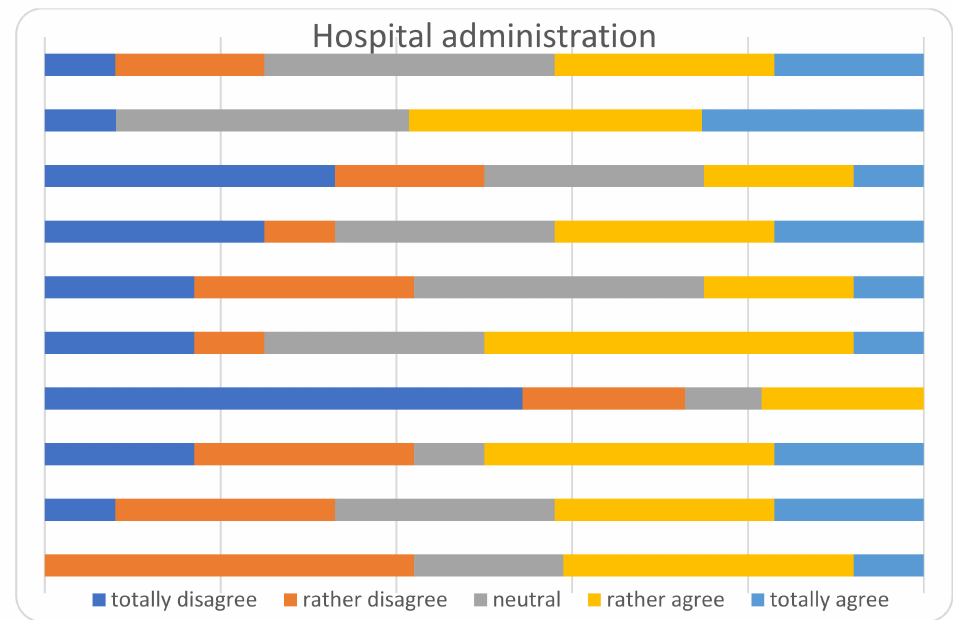
Figure 4. Perceived role of the hospital administration.